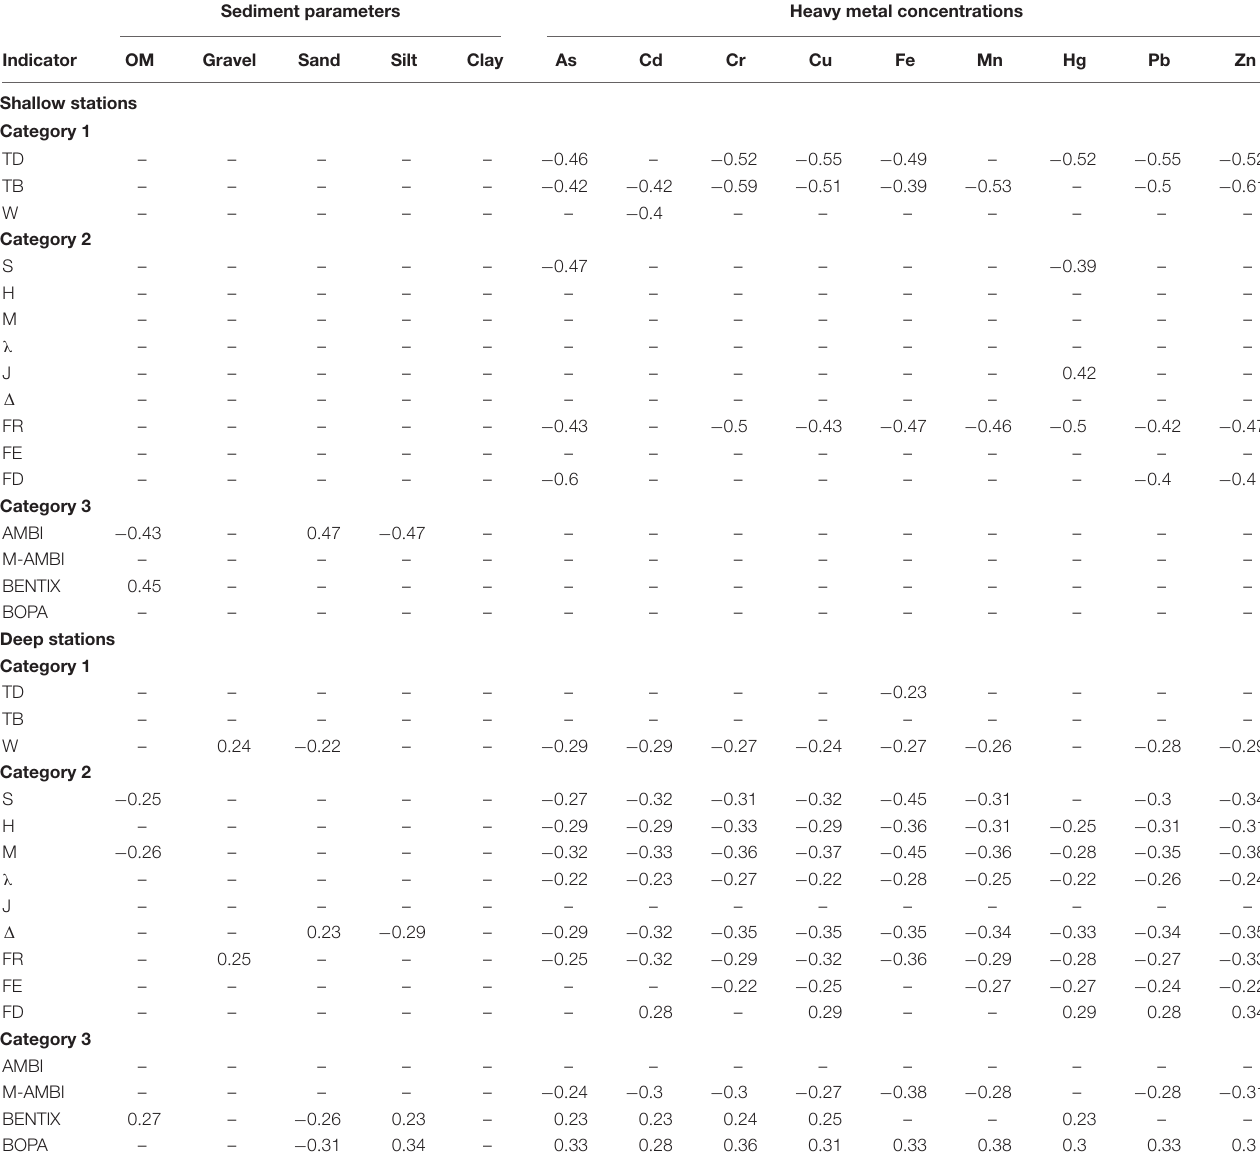
TABLE 5 | Spearman rank correlation coefficients between environmental indicators and habitat parameters, for shallow and deep stations. Sediment